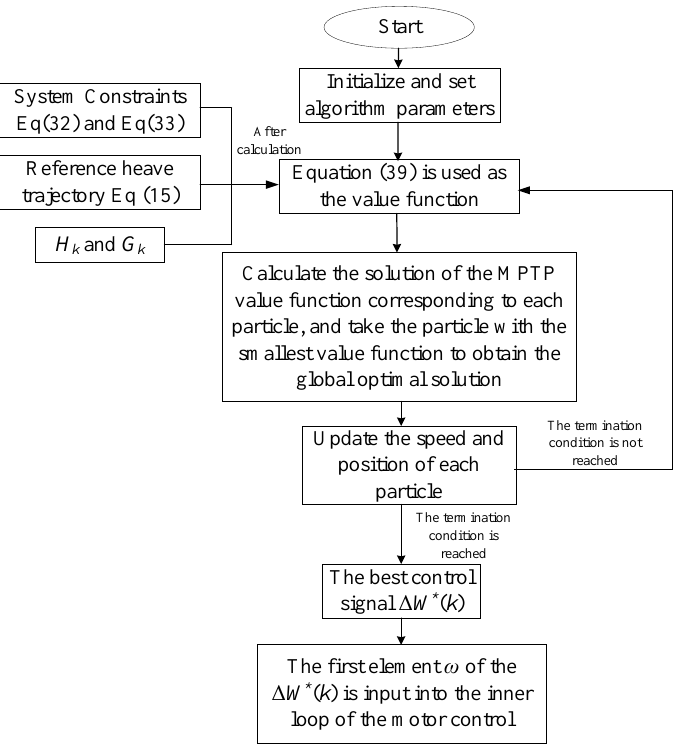
Figure 6. PSO optimizes MPTP process.